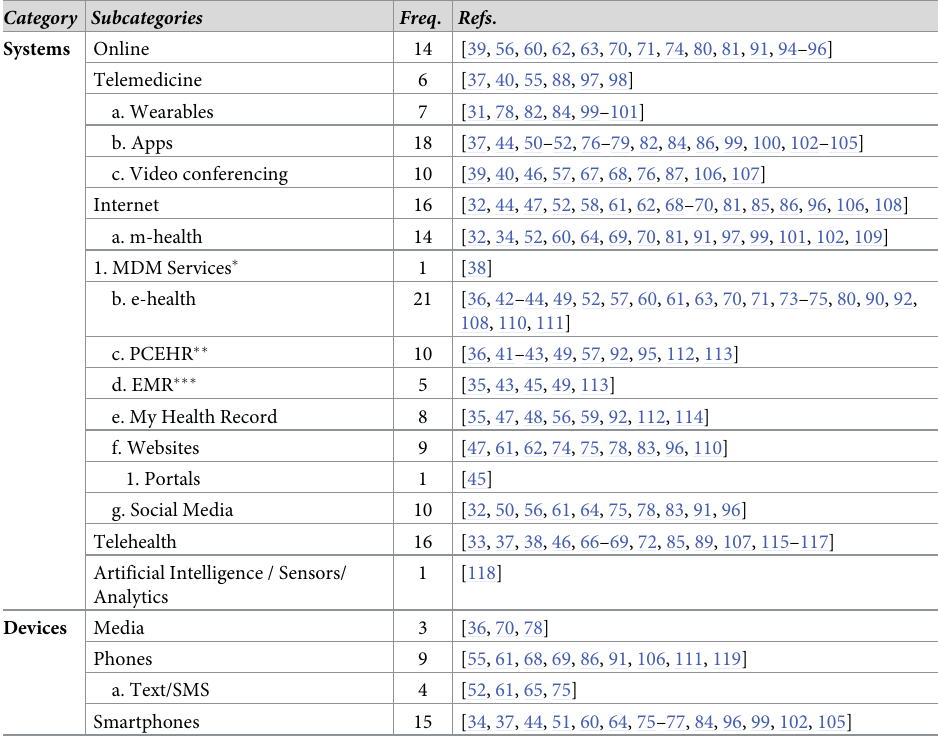
Table 5. Summary of findings in the reviewed literature: